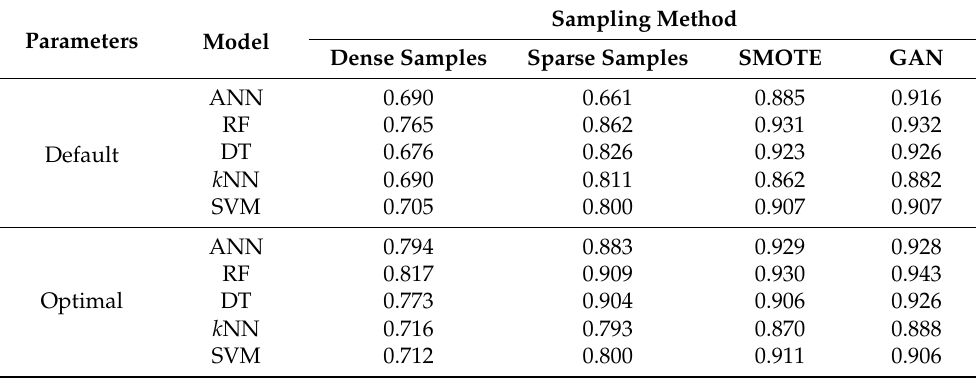
Table A3. Assessment of different sampling methods used in this study with five machine learning models (both default and optimised parameters)–based on F1-score.